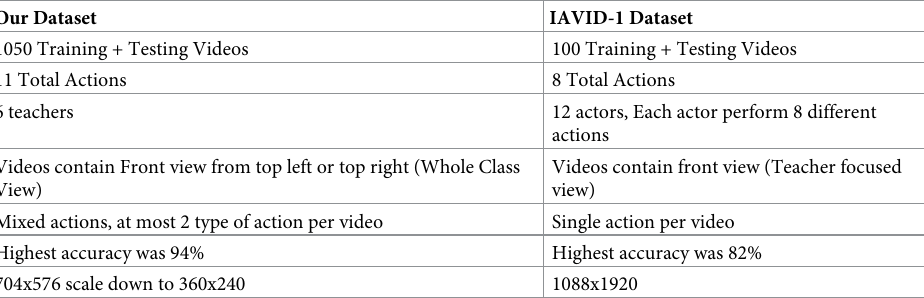
Table 2. Comparison with IAVID-1